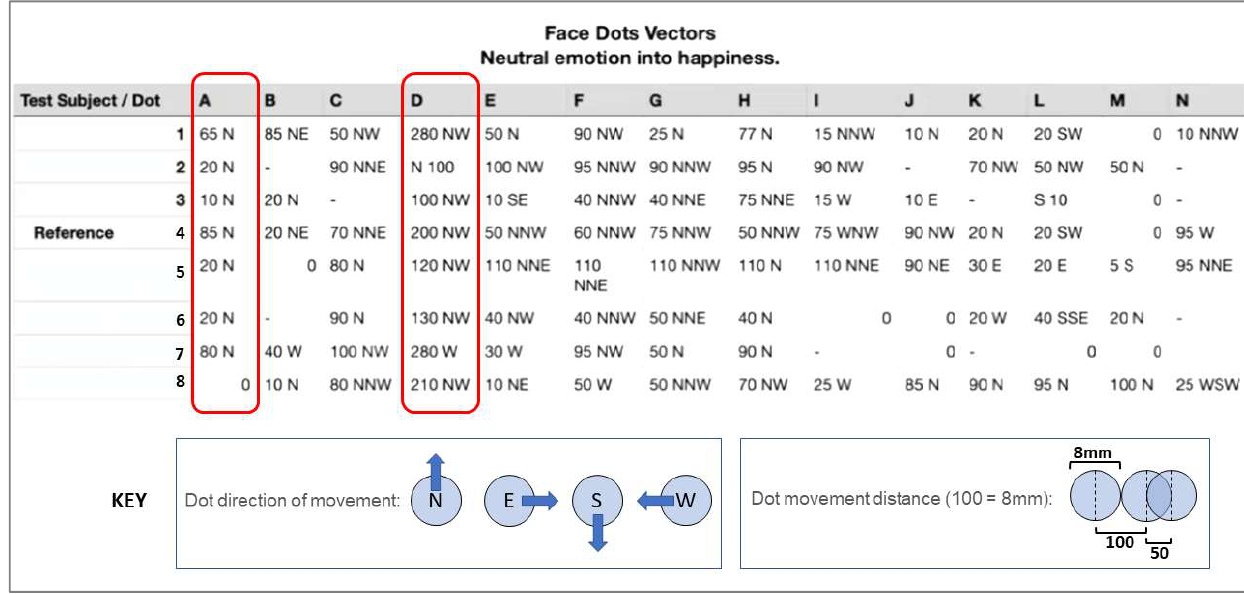
Figure 8. Face dot vector movement from neutral to smiling expression, taken from eight volun- teers.